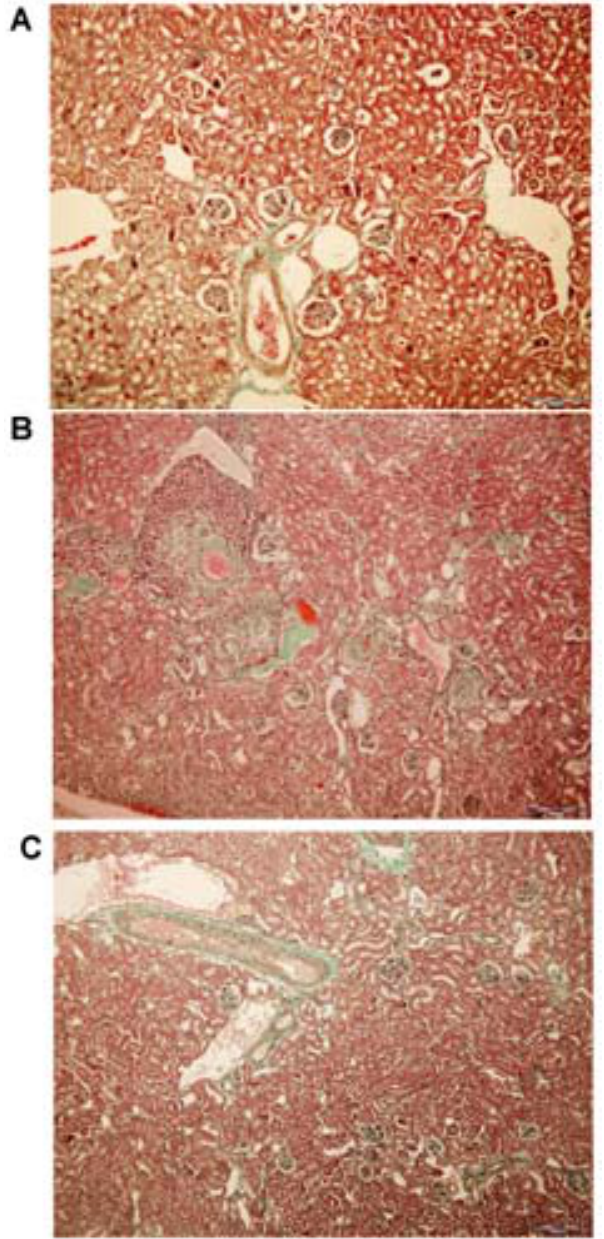
Figure 2. Improvement of renal histology following AT1 receptor antagonism. Representative example of renal cortical histology revealed by Mason’s trichrome in 12 month old wild type (A) and RenTg mice before (B) and after (C) 6 weeks of irbesartan administration. Note the substantial improvement of the renal histology following therapy with the AT1 receptor antagonist. Bar=200 m m.